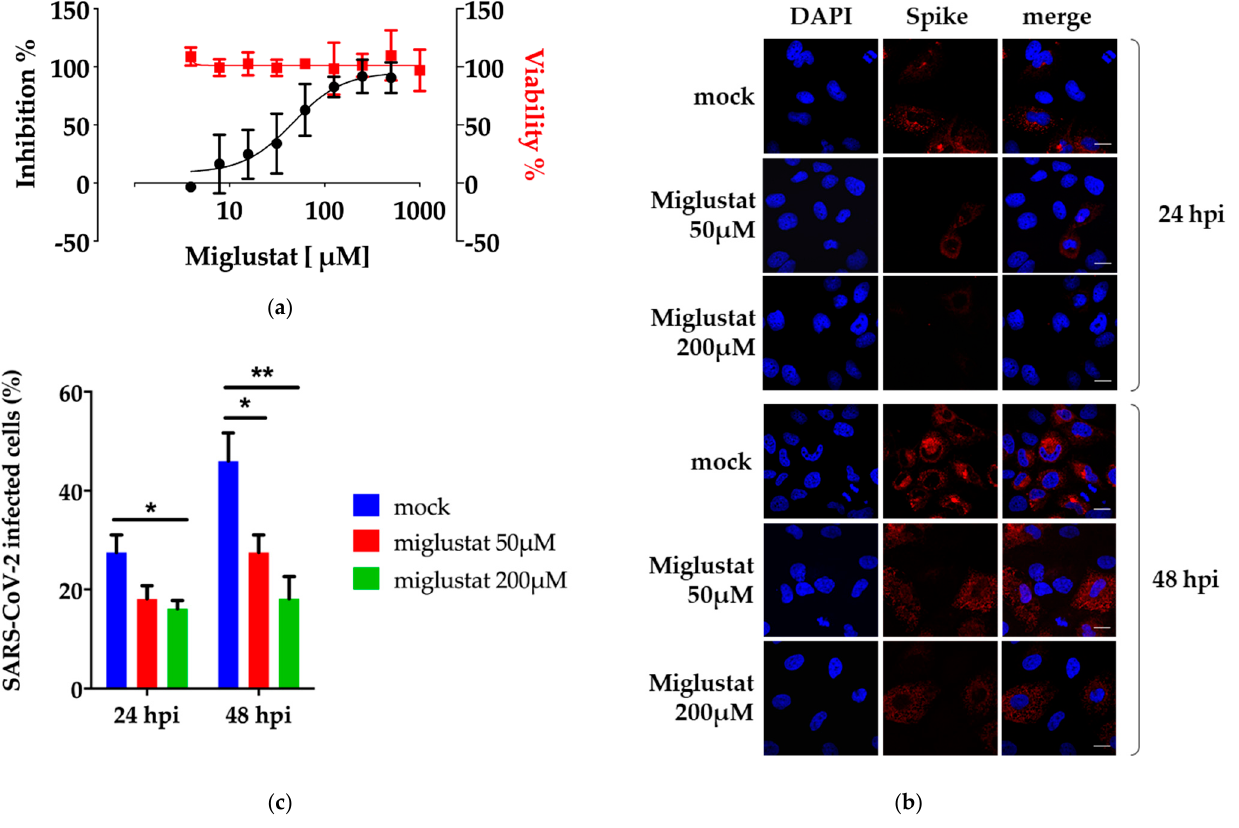
Figure 1. Anti-SARS-CoV-2 activity of Miglustat. ( a ) Antiviral plaque assay. Miglustat at the indicated concentrations was added to Vero E6 monolayers infected with SARS-CoV-2. Following incubation for three days, the cells were fixed and stained to count the viral plaques against vehicle control, which were plotted as the percent inhibitory activity (black dots). The cytotoxicity was measured by the Alamar blue method and data plotted as percent viability (red squares). ( b ) Immunofluorescence assay. Huh7 cells were infected with SARS-CoV-2 moi = 0.1 and incubated with Miglustat as indicated. The cells were then fixed and stained with mSIP-3022 antibody against Spike (red) to acquire confocal images. The nuclei were stained by DAPI. The bar corresponds to 20 μ m. ( c ) Quantification of infected cells. SARS-CoV-2 infected cells were counted. The results from 200 cells per condition were plotted as the percent of infected cells. Each pair of mock/treatment conditions was analysed and only significant differences are marked by the asterisks, significant p -values are indicated by ** p < 0.01 highly significant; * p < 0.05 significant, measured with a paired two-tailed t -test.